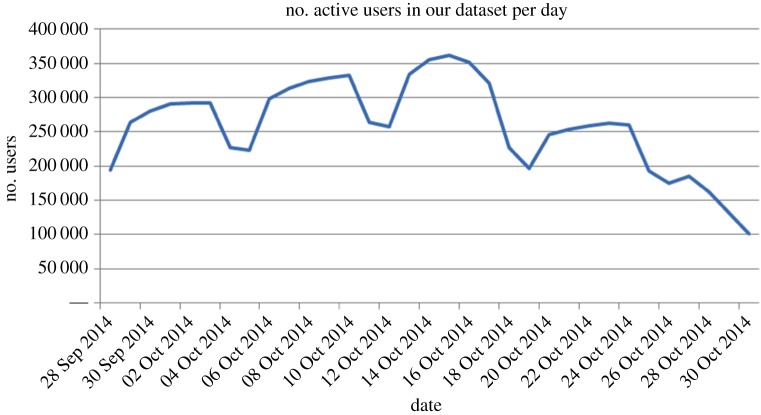
Number of active users per day for a restricted range of dates.